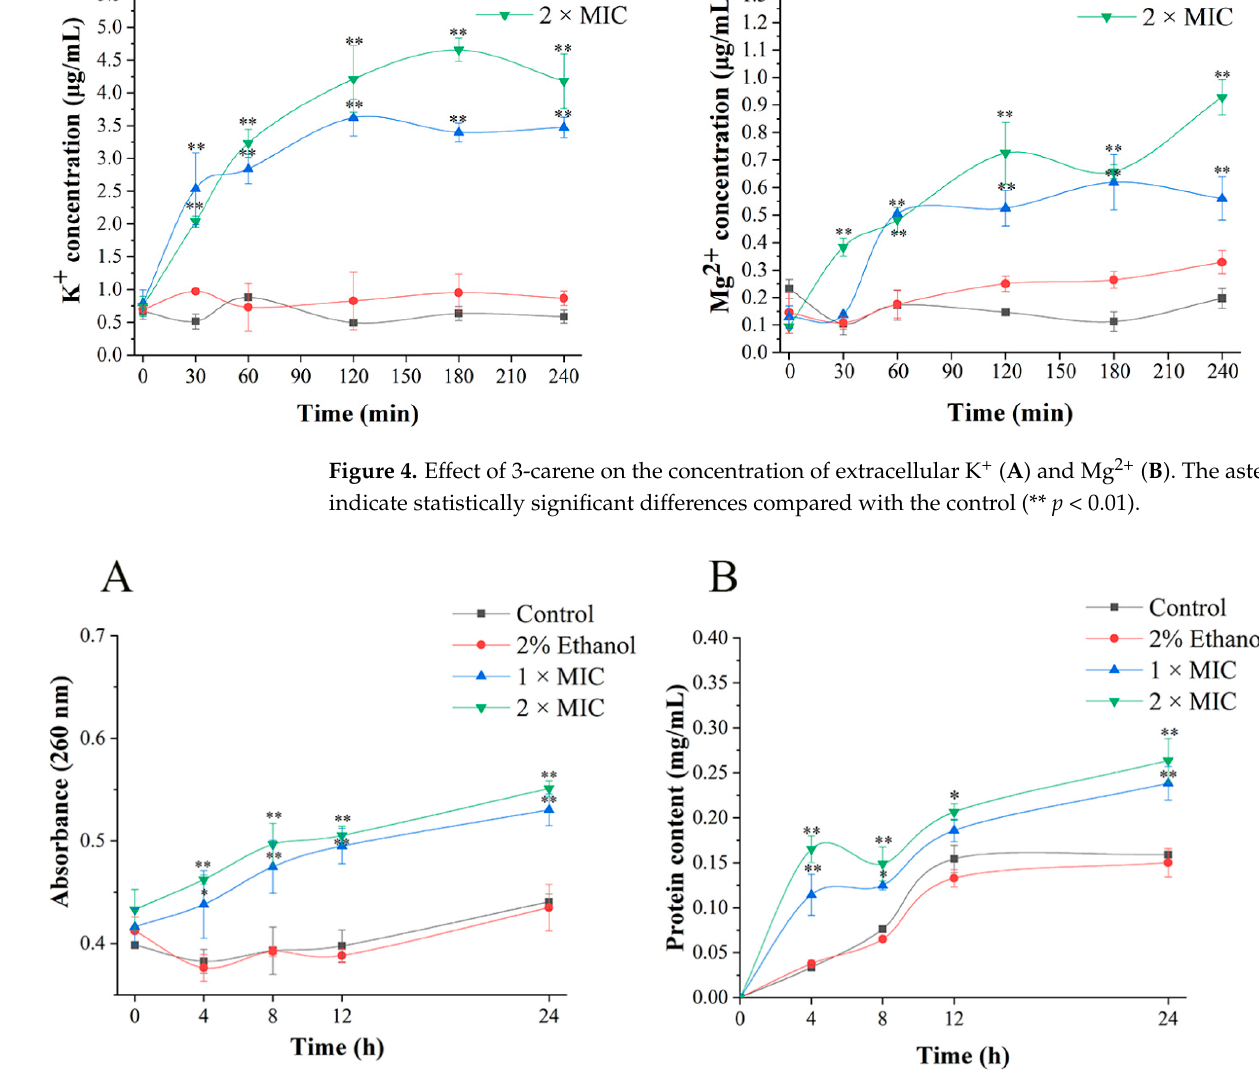
Figure 4. Effect of 3-carene on the concentration of extracellular K + ( A ) and Mg 2+ ( B ). The asterisks indicate statistically significant differences compared with the control (** p < 0.01).